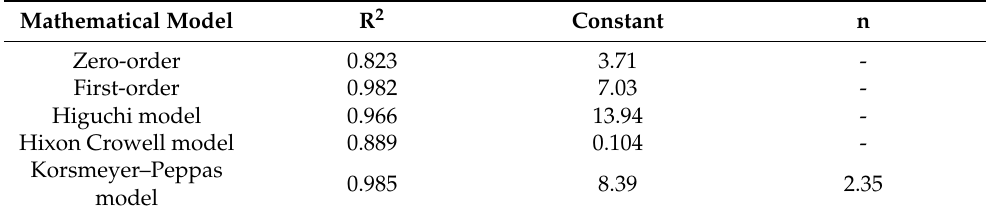
Table 7. The constant and coefficient of determination (R 2 ) and the “n” value for each mathematical model.